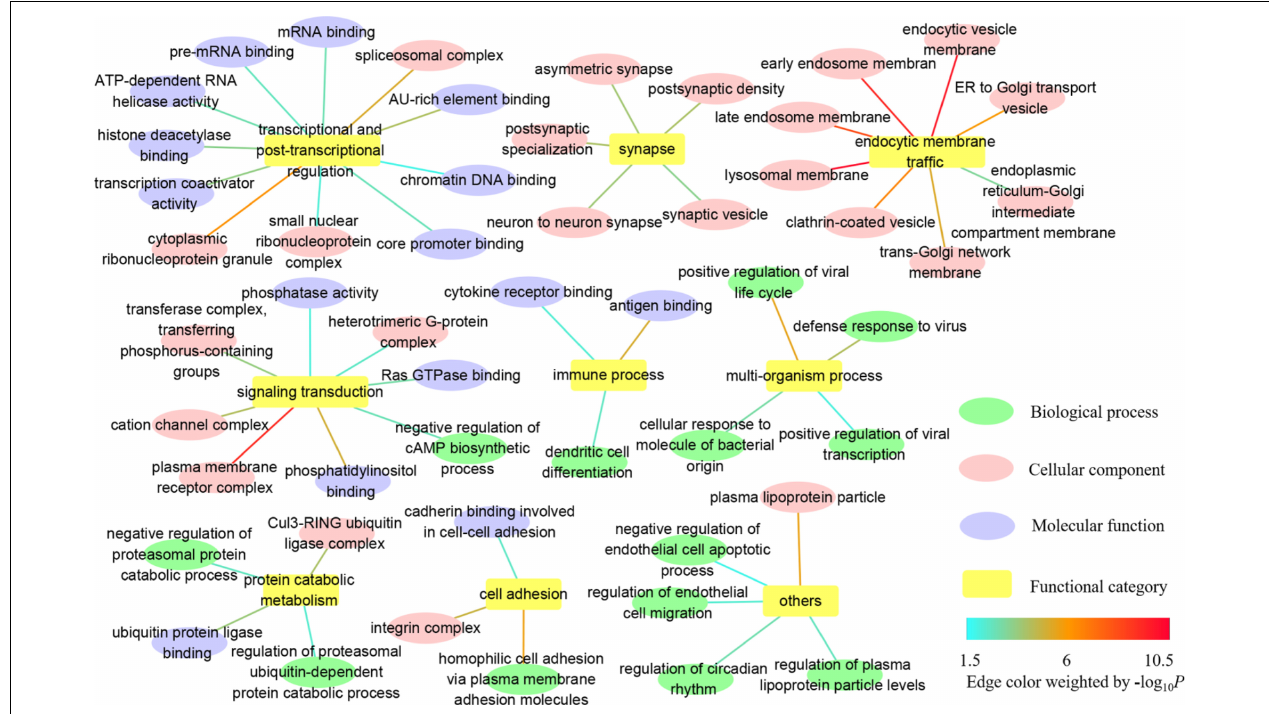
FIGURE 1 | Summarized GO annotation results shared by AD and IS. The complete GO annotation results shared by AD and IS are summarized and reorganized here, with only more fine-grained terms labeled and classified into different functional categories: transcriptional and post-transcriptional regulation, synapse, endocytic membrane traffic, signaling transduction, immune process, multi-organism process, protein catabolic metabolism, cell adhesion, and others, which are shown in nodes. The relevant GO terms of biological process, cellular component, and molecular function are shown in targets. The threshold for statistical significance for a GO term is P < 0.05 in both AD and IS. The edges connecting the nodes and targets are attributed by the value of –log 10 P